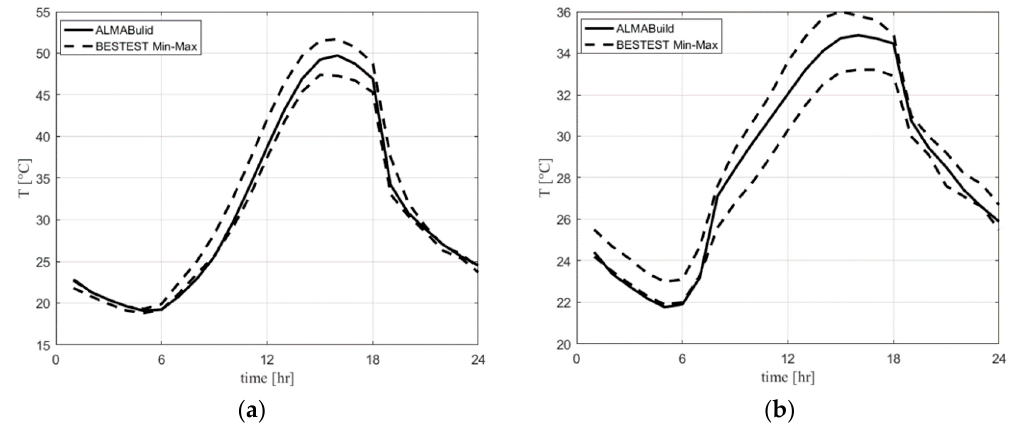
Figure 7. Trend of hourly free-floating internal air temperature for case 650 FF ( a ) and case 950 FF ( b ): comparison with the BESTEST limits.